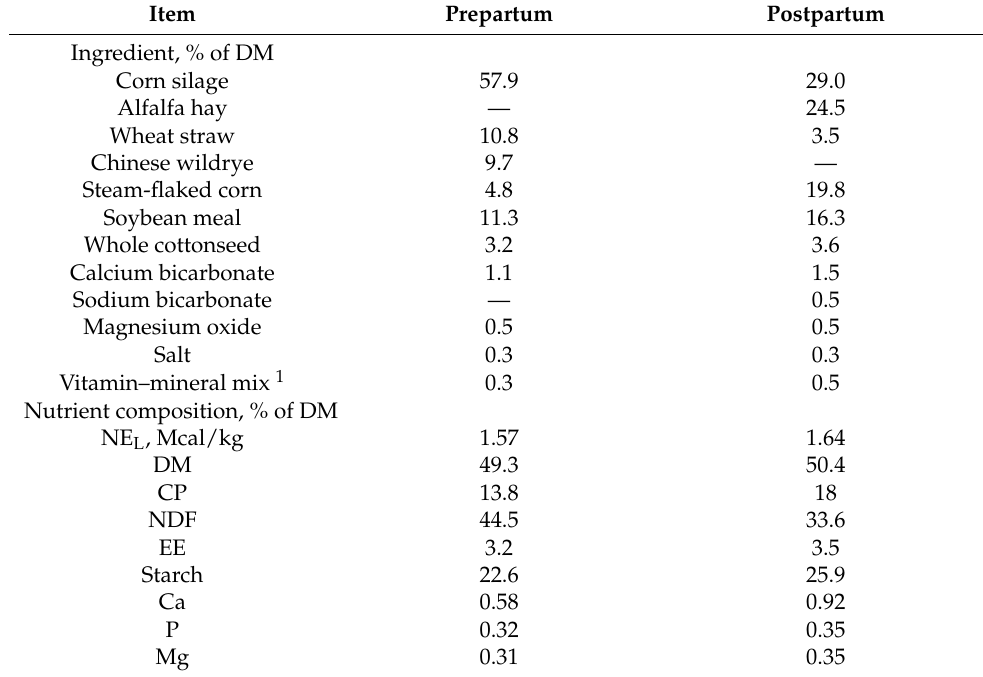
Table 1. Dietary ingredients and nutrient compositions of diets fed prepartum and